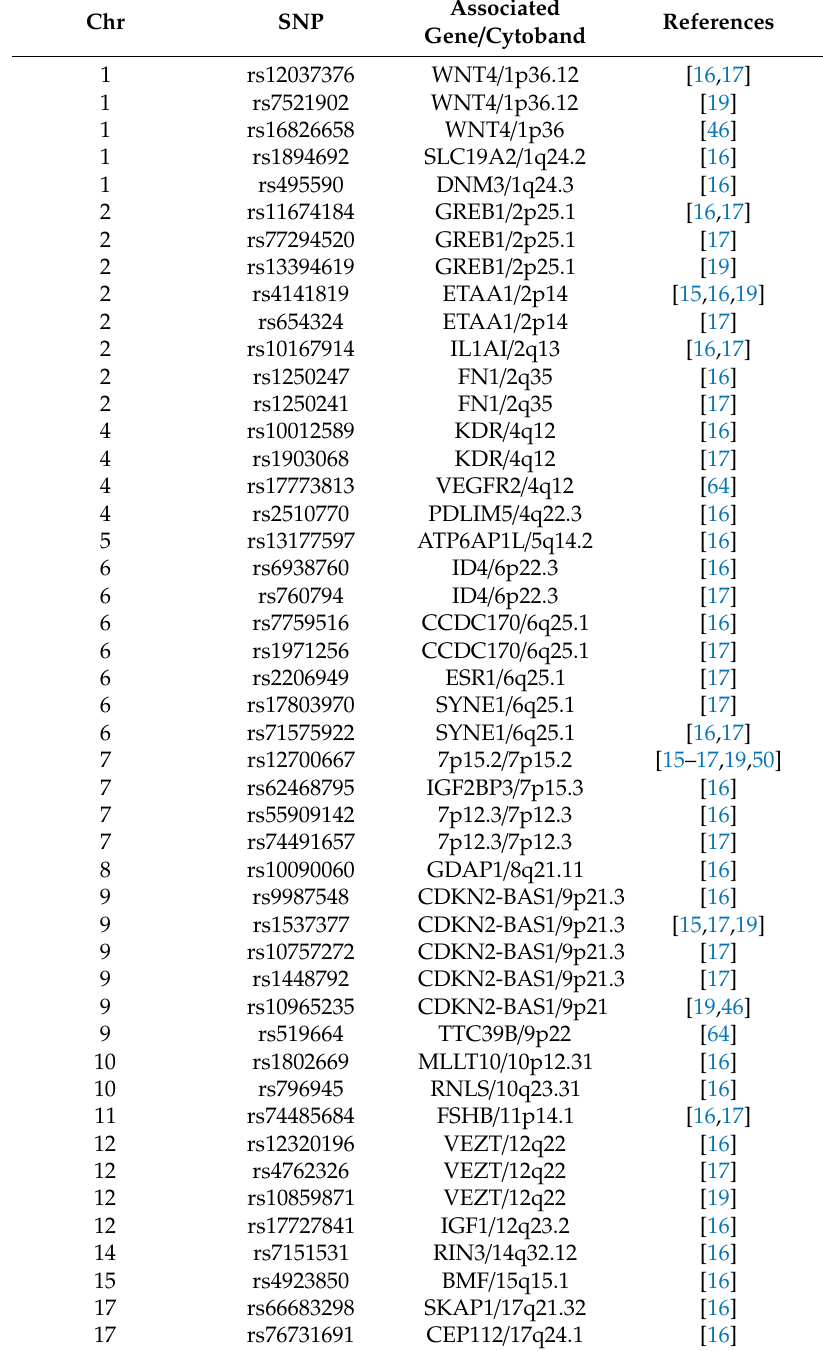
Table 1. Review of the selected genetic polymorphisms for the significant loci in the entire genome associated with the development of